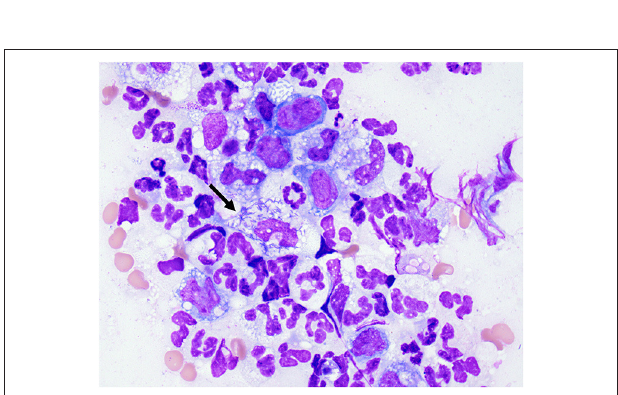
FIGURE 2 | Cytology of pleural fluid. Photomicrograph of pleural effusion. Mixed inflammation, neutrophils and variably vacuolated macrophages. Neutrophil (arrow) with phagocytosed intracellular thin bacilli. Wright-Giemsa stain 100 × oil objective.